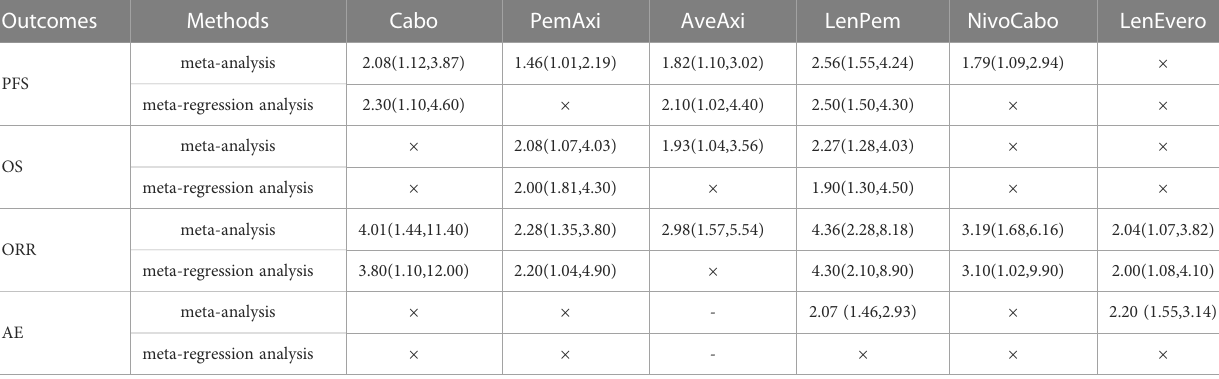
TABLE 4 Outcomes of interest in intent-to-treat population compared to Sunitinib before and after meta-regression (shown as hazard ratio and 95% credible intervals). Outcomes